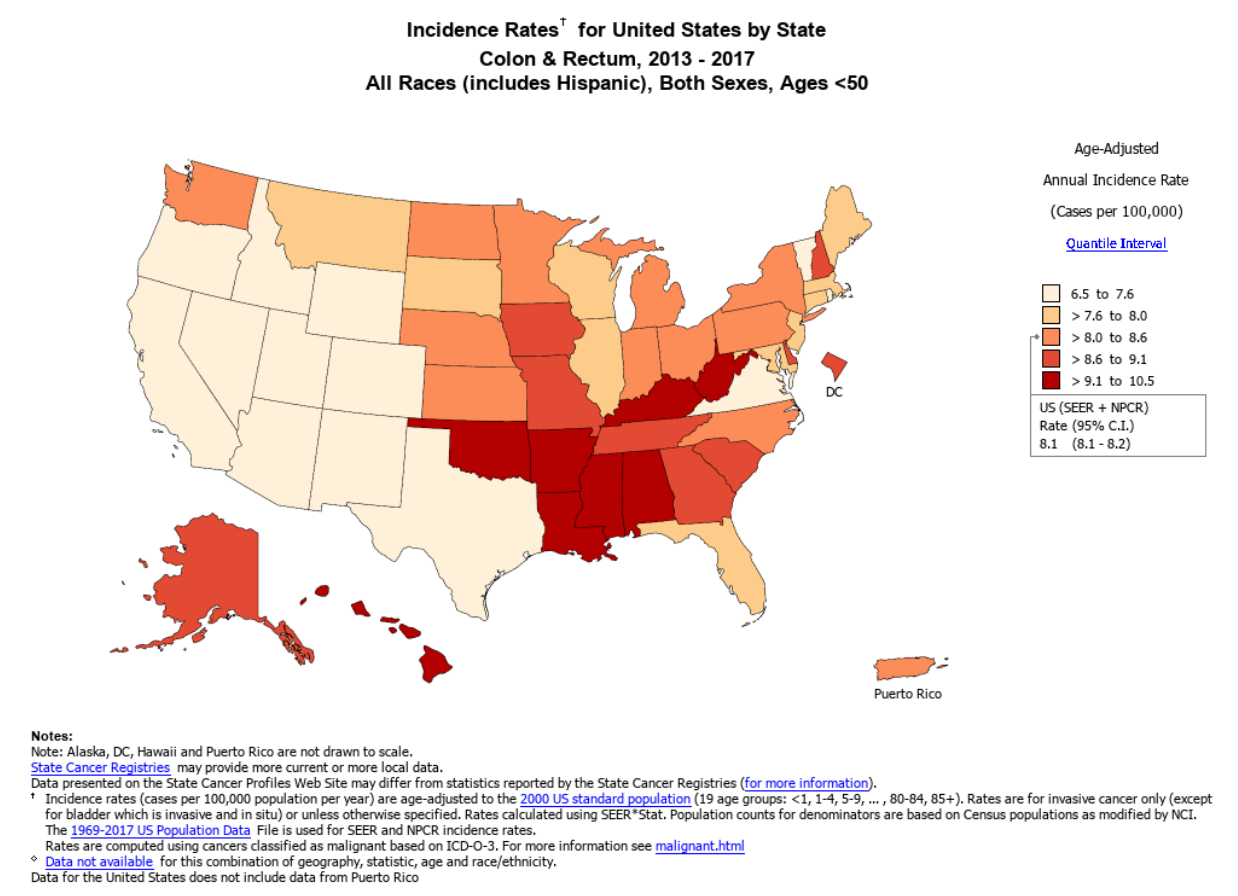
Figure 3. Incidence rates of early-onset CRC (Ages < 50) by US state, 2013–2017 from SEER registry [39].